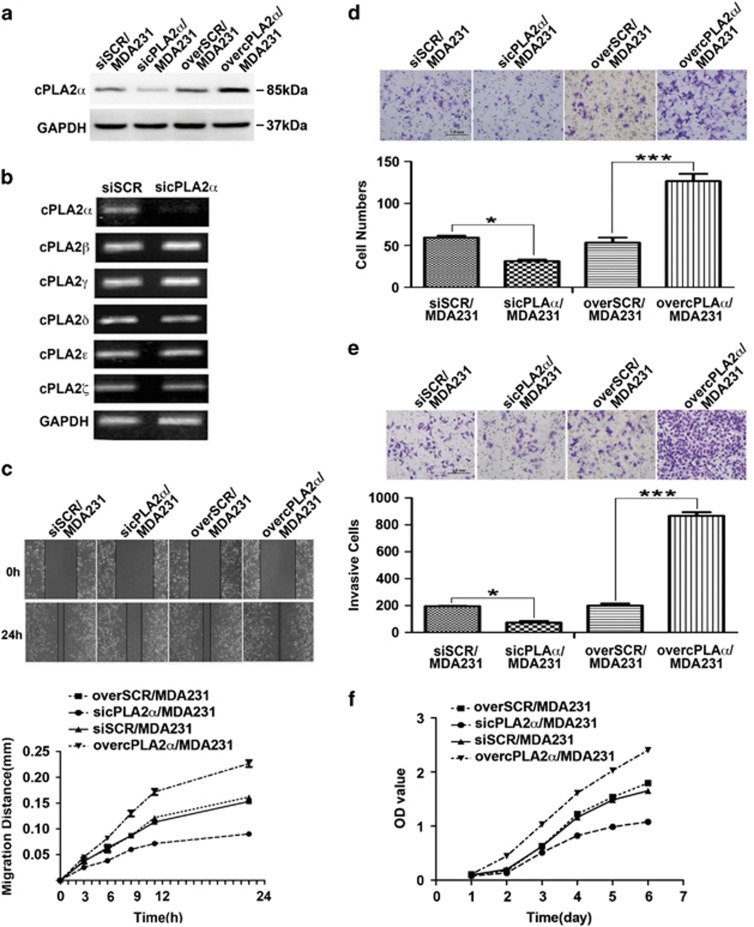
cPLA2α regulated MDA-MB-231 cell migration and invasion capacities in vitro. (a) Assessment of the transfected efficiency of cPLA2α protein expression after retroviral infection in MDA-MB-231 cells. (b) Repression specificity of cPLA2α mRNA expression in MDA-MB-231 cells by qRT-PCR. (c) Scratch assay comparing the migration of SCR/MDA-MB-231, sicPLA2α /MDA-MB-231 and overcPLA2α/MDA-MB-231 cells. (d) Comparison of chemotaxis potential of SCR/MDA-MB-231, sicPLA2α MDA-MB-231 and overcPLA2α/MDA-MB-231 cells under the application of high concentration of FBS (20%) with constant stimulation for 4 h. (e) Comparison of the invasion potential of SCR/MDA-MB-231, sicPLA2α/MDA-MB-231 and overcPLA2α/MDA-MB-231 cells after incubation with EGF (10 ng/ml) at 37 °C in 5% CO2 for 24 h by counting the number of the cells that invaded through Matrigel-coated transwell inserts. (f) Comparison of the proliferation of SCR/MDA-MB-231, sicPLA2α/MDA-MB-231 and overcPLA2α/MDA-MB-231 cells by Cell Counting Kit-8 (CCK8) assay. **P<0.01 and ***P<0.001. Scale bar, 1.0 mm. All experiments were repeated at least three times